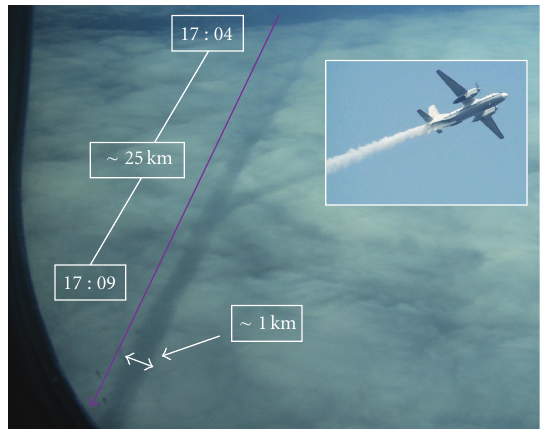
Figure 3: The photo is taken by the aircraft (XY-II) after the spreading. It shows a direct evidence that after the spreading of diatomite particles, there is clearly a cloud breaking region along the spreading route. The flight was taken on September 19, 2005 from 17:04 to 17: 09 pm with 5 minutes. The flight speed is about 300km/hr, and flight height of 4.5km during spreading time. The estimated length and width are approximately 25 and less than 1km, respectively. The right-upper panel illustrates the spreading of particles.